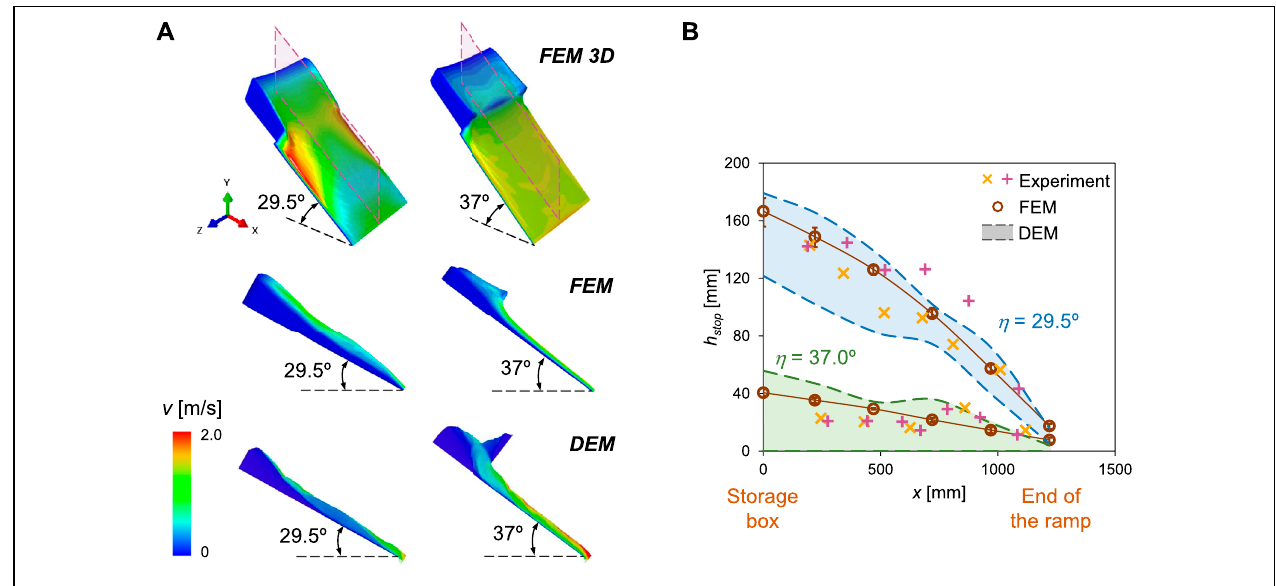
FIGURE 5 | (A) Qualitative comparison of the predicted material profile overlapped with velocity distribution at a steady-flow state for two inclination angles. (B) Quantitative comparison of the stopping thickness h stop of the material among the FEM and DEM model predictions and physical measurements.